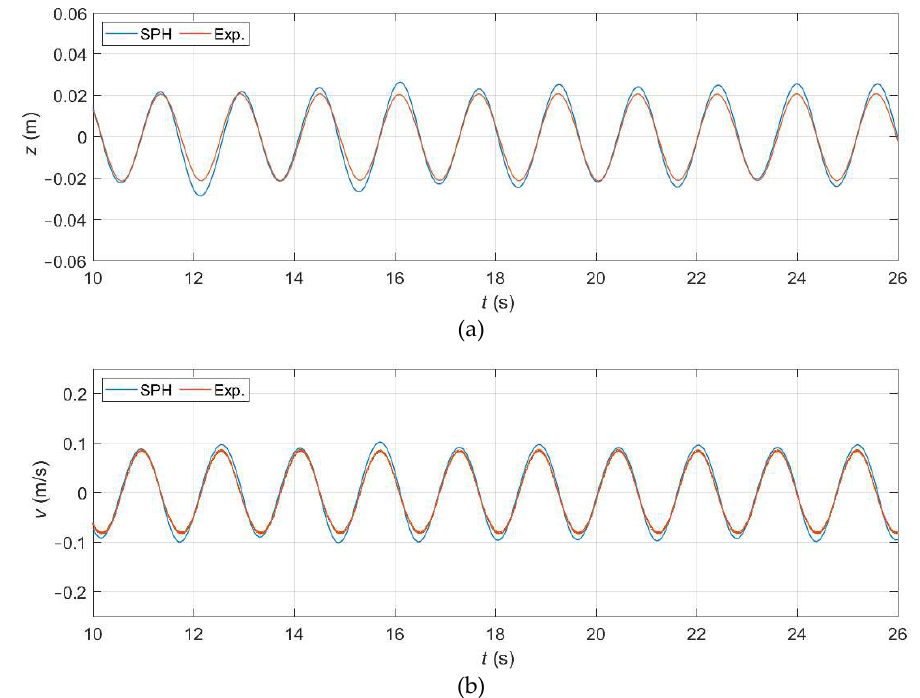
Figure 17. Numerical and experimental time series of the heave position ( a ) and velocity ( b ) with a closed-loop system.